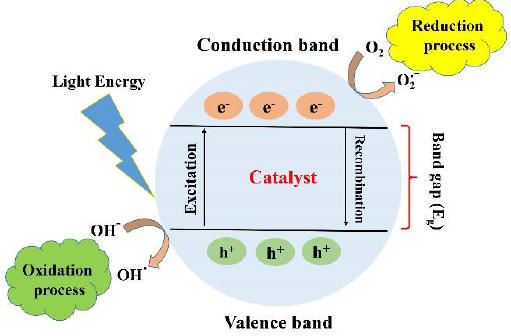
Figure 2. Schematic illustration of the photocatalytic mechanism. With permission from [18].